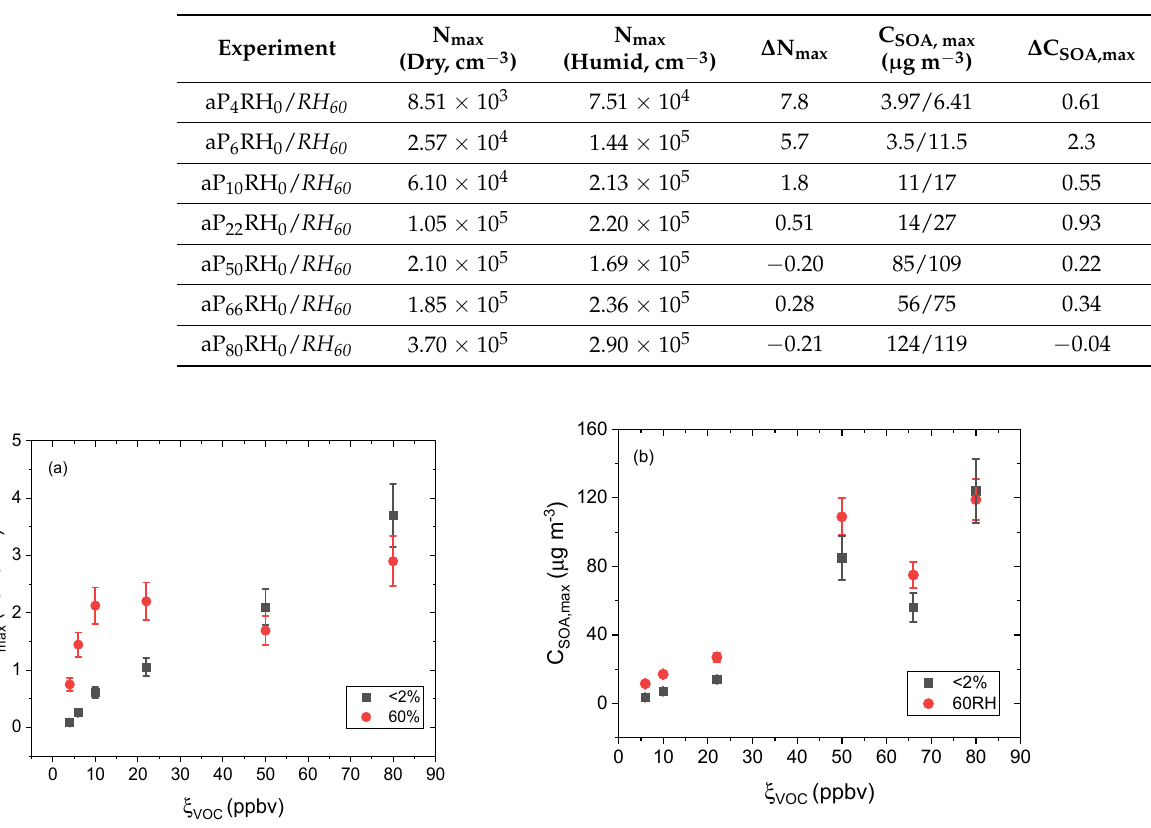
Figure 2. Maximum ( a ) number density (N max ) and ( b ) SOA mass obtained from ozonolysis of α -pinene at ( (cid:4) ) <2% and ( ● ) 60% RH as a function of ξ VOC . Relative standard deviation (n = 4), measured experimentally for experiments aP 6 RH 0 and aP 6 RH 60 , was applied to all other experimental